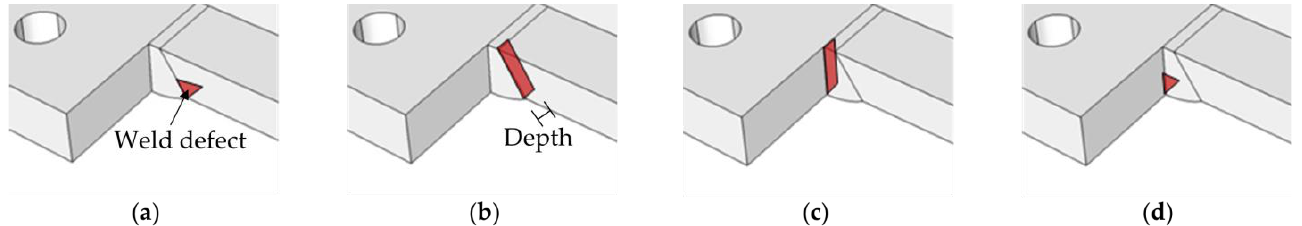
Figure 3. Locations and shapes of the defects: ( a ) flange surface crack (FSC), ( b ) flange through crack (FTC), ( c ) diaphragm through crack (DTC), and ( d ) diaphragm surface crack (DSC). Table 1. Experimental variables for the specimens.